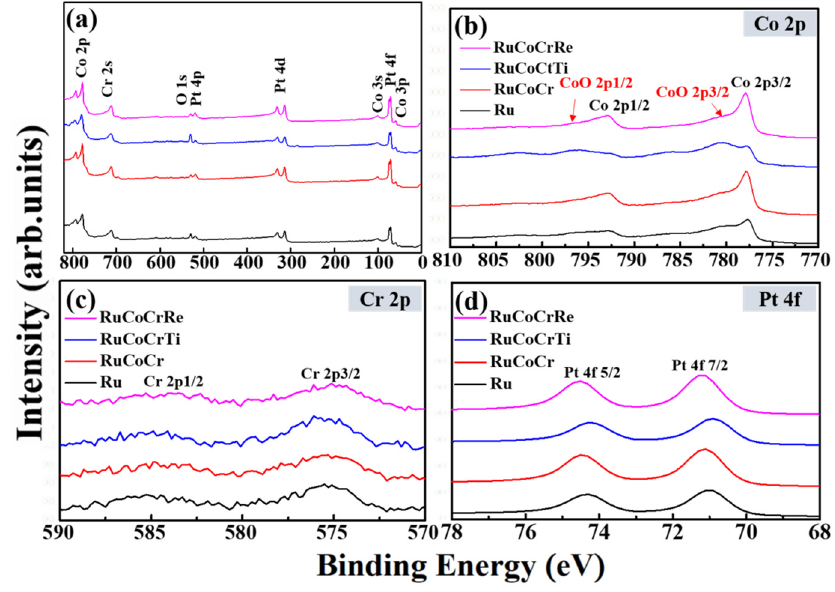
Figure 6. XPS spectras of CoCrPt magnetic layer, (a) full spectra, (b) Co, (c) Cr, (d) Pt.